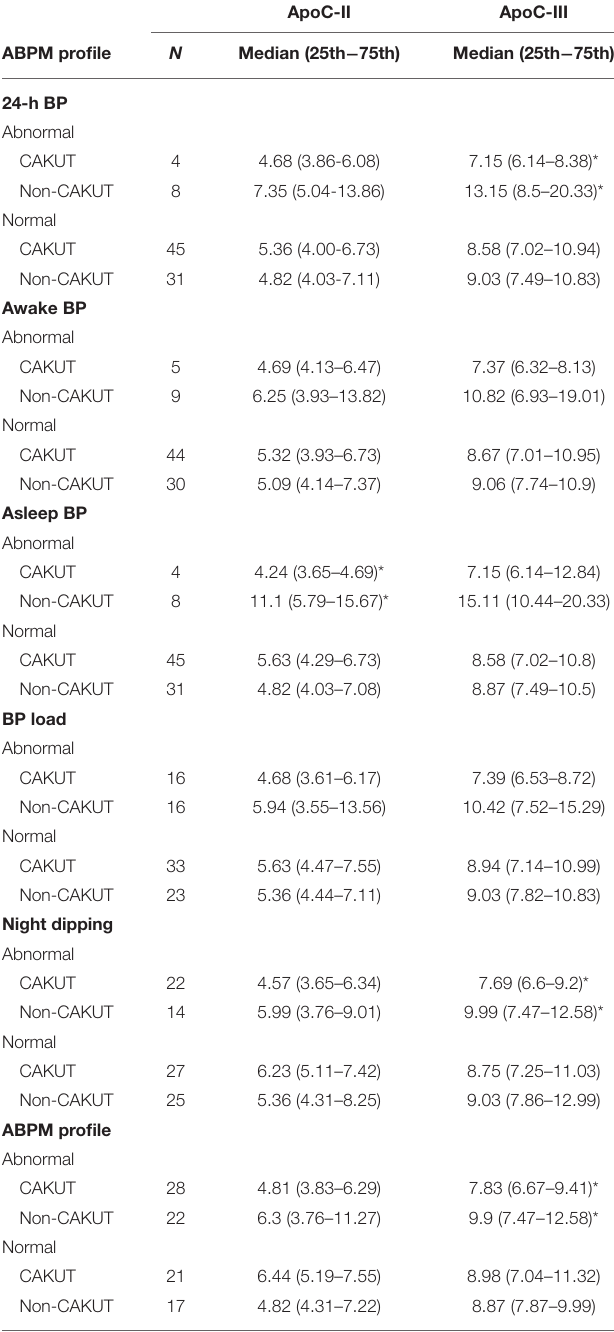
TABLE 6 | Comparison of plasma apoC-II and apoC-III levels according to the ABPM profile between the CAKUT and non-CAKUT CKD children and